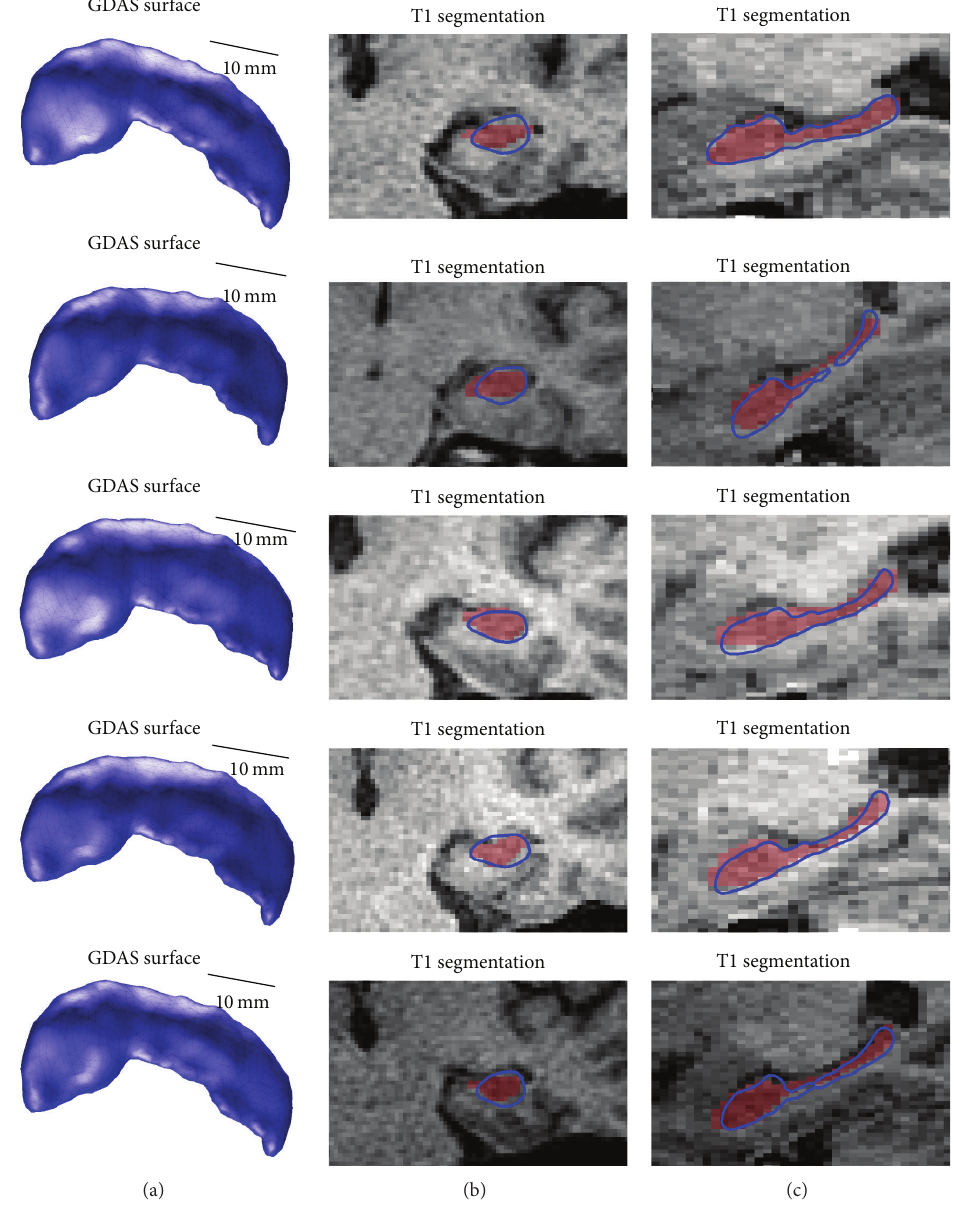
Figure 6: Example segmentations of T1 images using GDAS image segmentation based on inside-outside modelling. The resulting surfaces are shown on the left-hand side, and T1 images with gold standard (red highlight) and segmentation (blue curve) are shown in coronal (center) and sagittal (right)